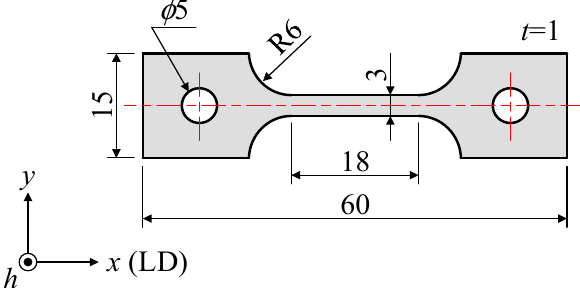
Figure 1. Shape and size of the plate specimen (in mm) [24]. Table 1. Load at each step.